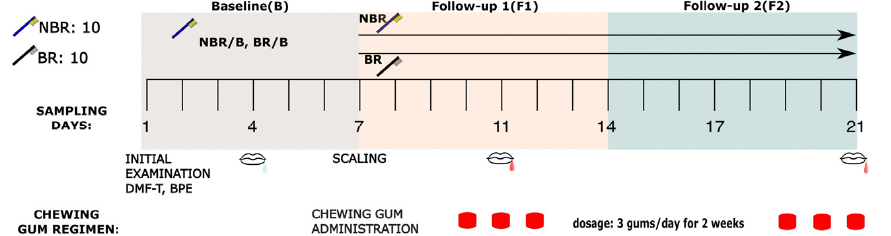
Figure 1. The 21 days of experimental protocol: The timescale (Periods of 1-week Baseline: B, 2-week chewing of anthocyanin gum in three pieces/day dosage. Follow-up 1 and 2: F1 and F2) of the experiment demonstrating the clinical procedures and sampling appointments. Scaling was made on the last occasion of B period, whereafter the participants started to chew the gum. After scaling made on the 7th day of B period, 10 subjects were randomly classified into NBR (who changed the toothbrush after scaling) and 10 into BR groups (subjects who did not change their toothbrush after scaling), and they got sour cherry chewing gums in three pieces/day dosage. The groups differed only by changing the toothbrush or not after scaling. The text under sampling days shows the actual intervention made at that time. During the B period (B: Day 4), sampling was made without sour cherry chewing gum usage (mouth with colorless drop). The chewing gum usage and sampling of the F1 and F2 period (F1: Day 4 and F2: Day 7) is shown by a mouth with red